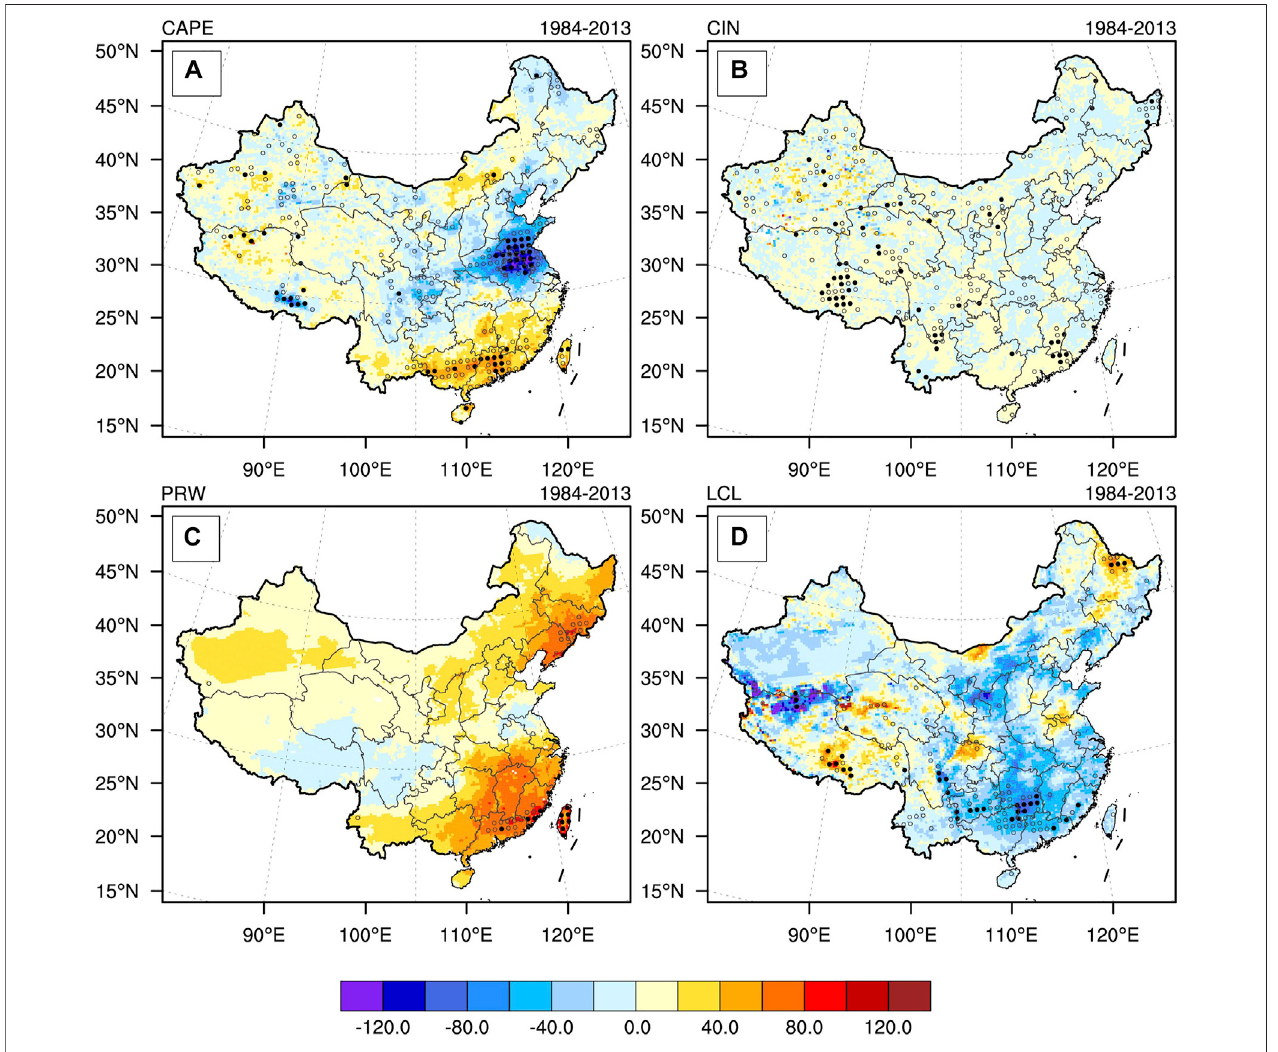
FIGURE 9 | Same as Figure 7 , but for (A) convective available potential energy (units: J/kg), (B) convection inhibition energy (units: J/kg), (C) atmospheric water vapor content (units: 10 − 2 mm) and (D) lifting condensation level (units: m). The meaning of the solid (hollow) black dots is the same as in Figure 5 .